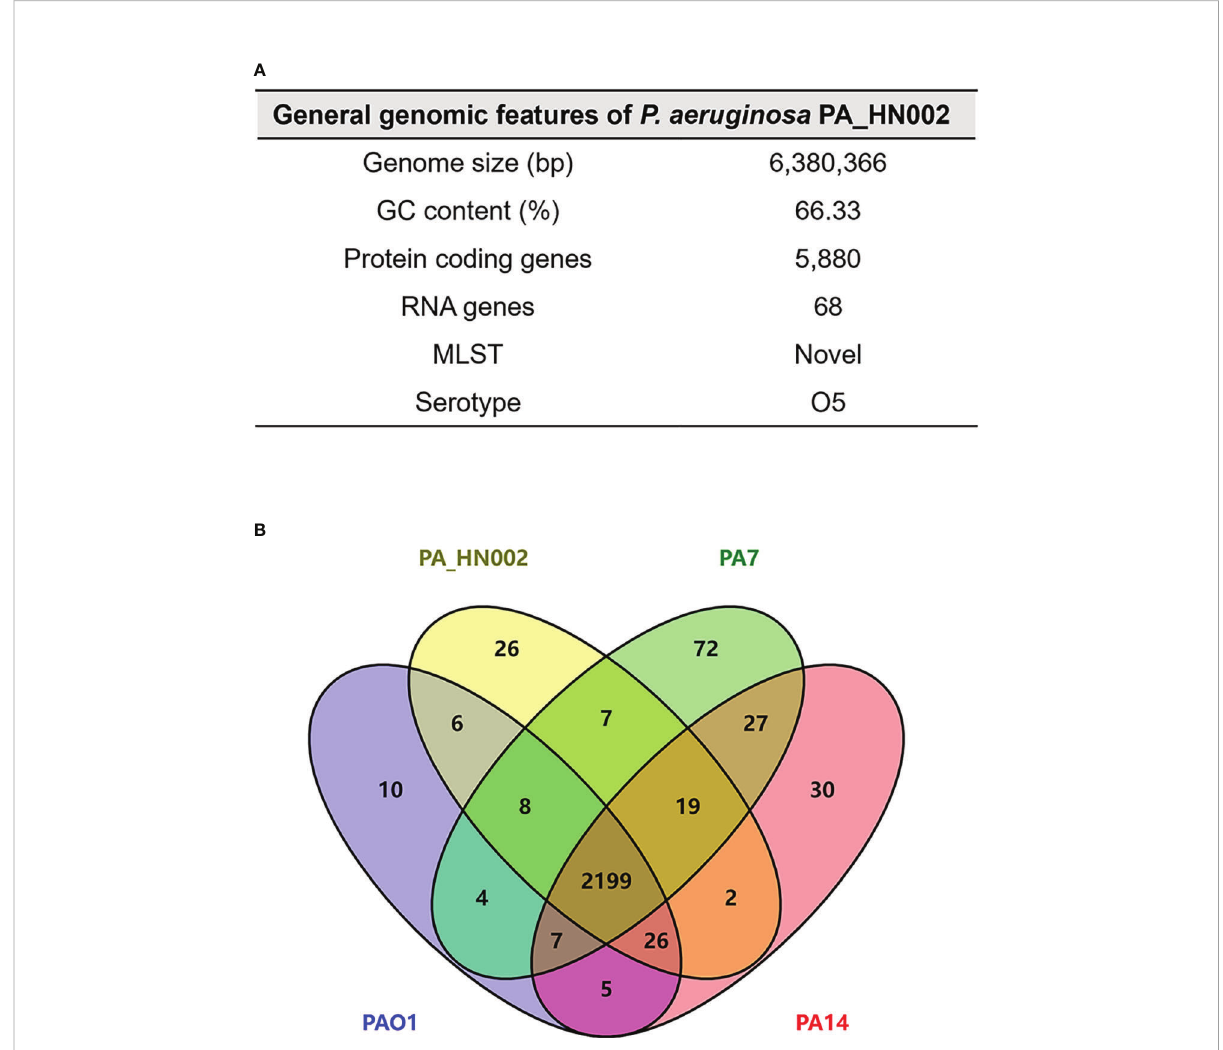
FIGURE 3 General features of the PA_HN002 genome. (A) General features of the PA_HN002 genome including genome size, GC content, protein coding genes, RNA genes, MLST and serotype. (B) Venn diagram showing the number of shared and exclusive genes among PA_HN002, PAO1, PA7 and PA14. The numbers indicated the unique genes, shared genes among two, three or four strains based on the COG gene